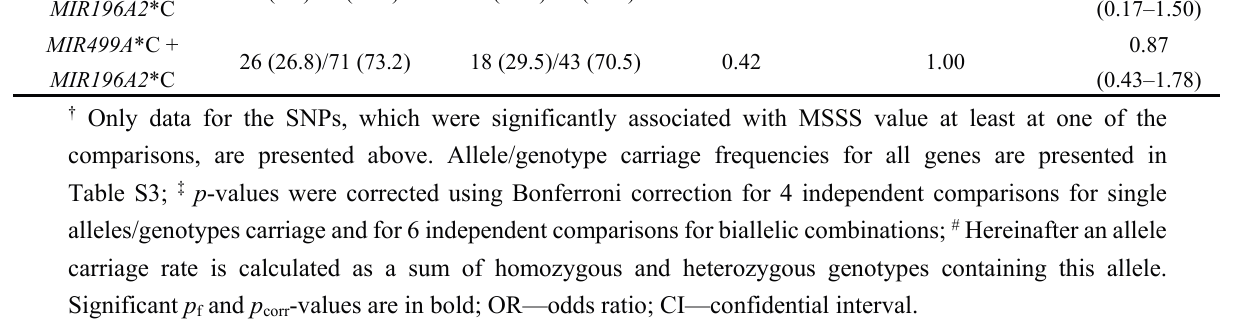
comparisons, are presented above. Allele/genotype carriage frequencies for all genes are presented in Table S3; ‡ p -values were corrected using Bonferroni correction for 4 independent comparisons for single alleles/genotypes carriage and for 6 independent comparisons for biallelic combinations; # Hereinafter an allele carriage rate is calculated as a sum of homozygous and heterozygous genotypes containing this allele. Significant p f and p corr -values are in bold; OR—odds ratio; CI—confidential